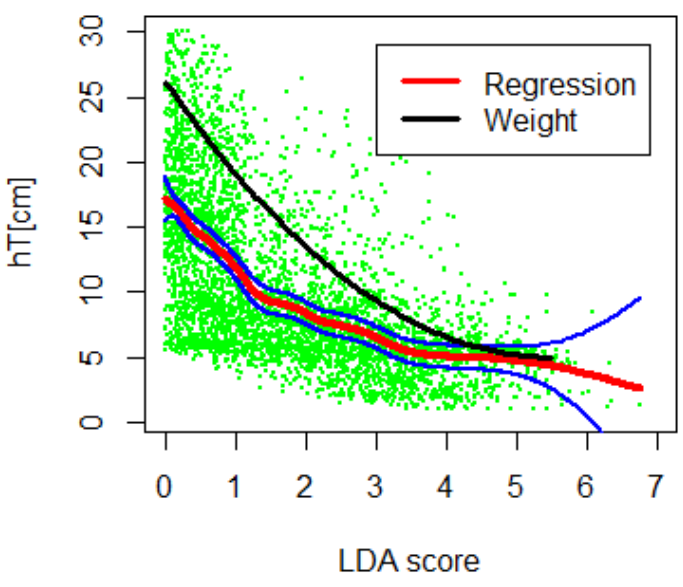
Figure 6. The linear discriminant analysis (LDA) scores ( s ) vs. The MODIS thicknesses ( h T ) in our reference data set collected mainly in the Barents and Kara Sea. We included only h T values up to 30 cm and the corresponding LDA scores ( s > 0). The regression function with 99% confidence interval as well as the weight function are shown.